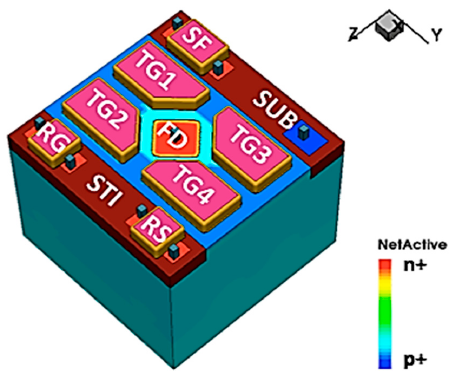
Figure 11. TCAD 3D model of a 4-way shared readout jot, from [20].